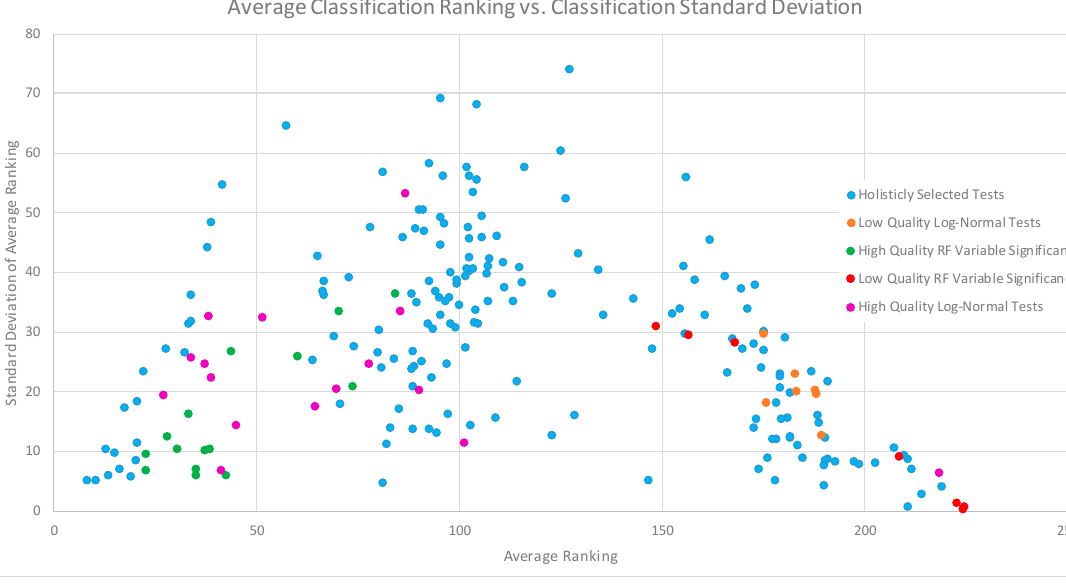
Figure 5. Scatter plot of average classification ranking versus classification standard deviation for each test. Results are broken down by classification input selection type.